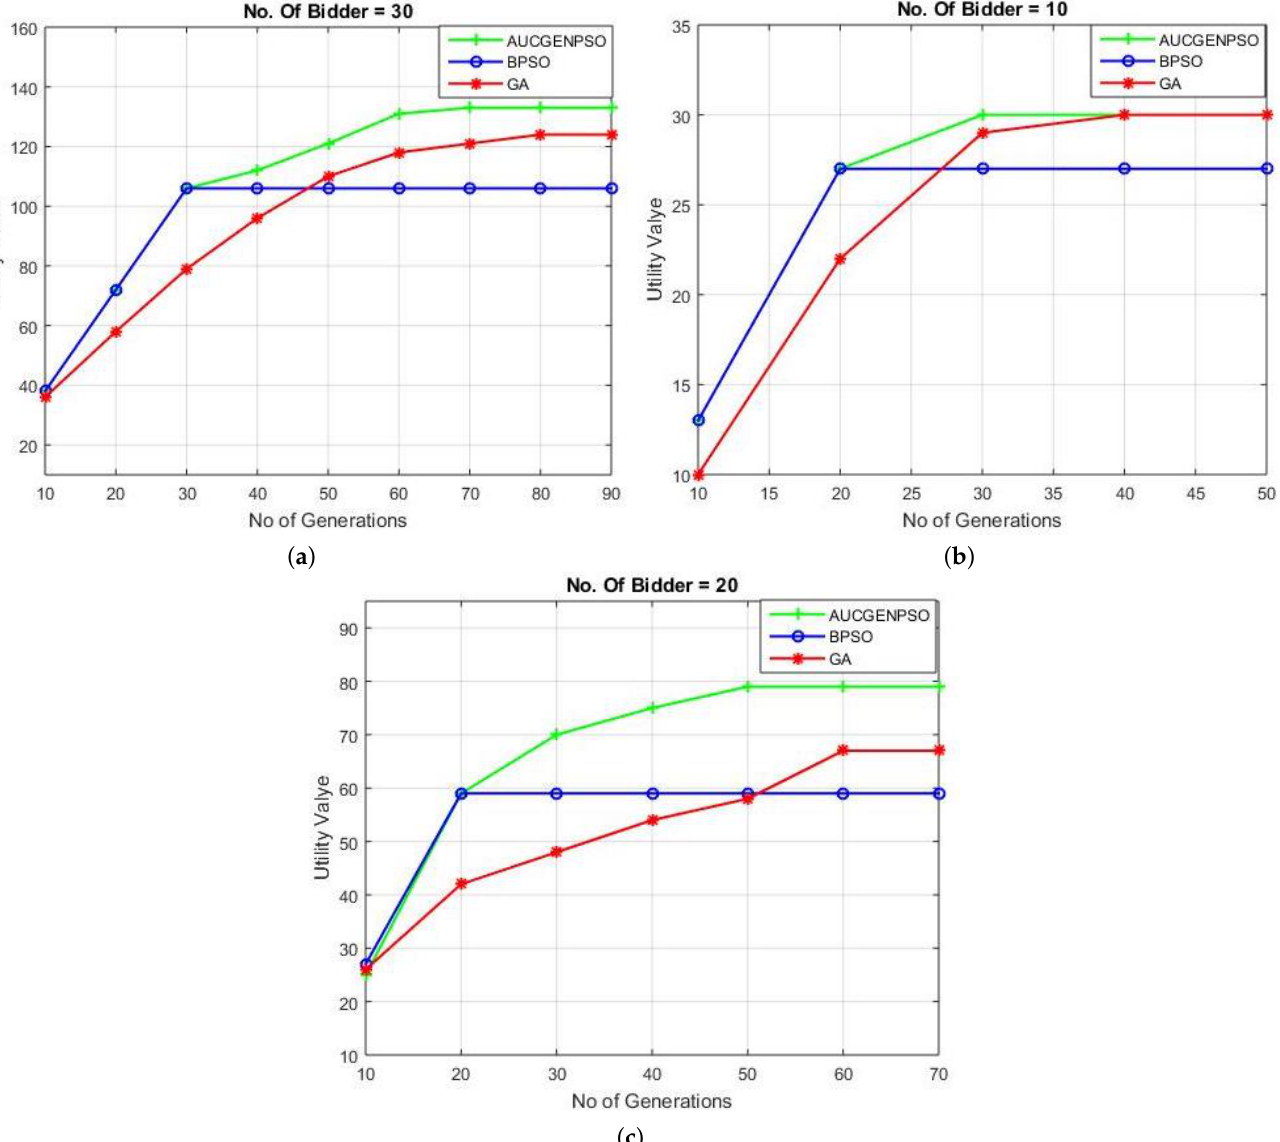
Figure 10. Optimality results ( a ) no. of bidders = 10, ( b ) no. of bidders = 20, ( c ) number of bidders =